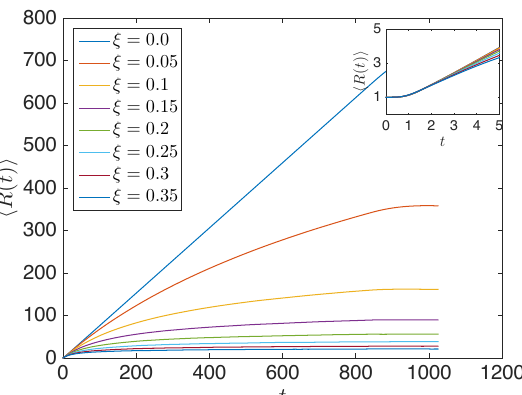
) during impulse propagation for granular chains R ( t ) (cid:104) (cid:105)